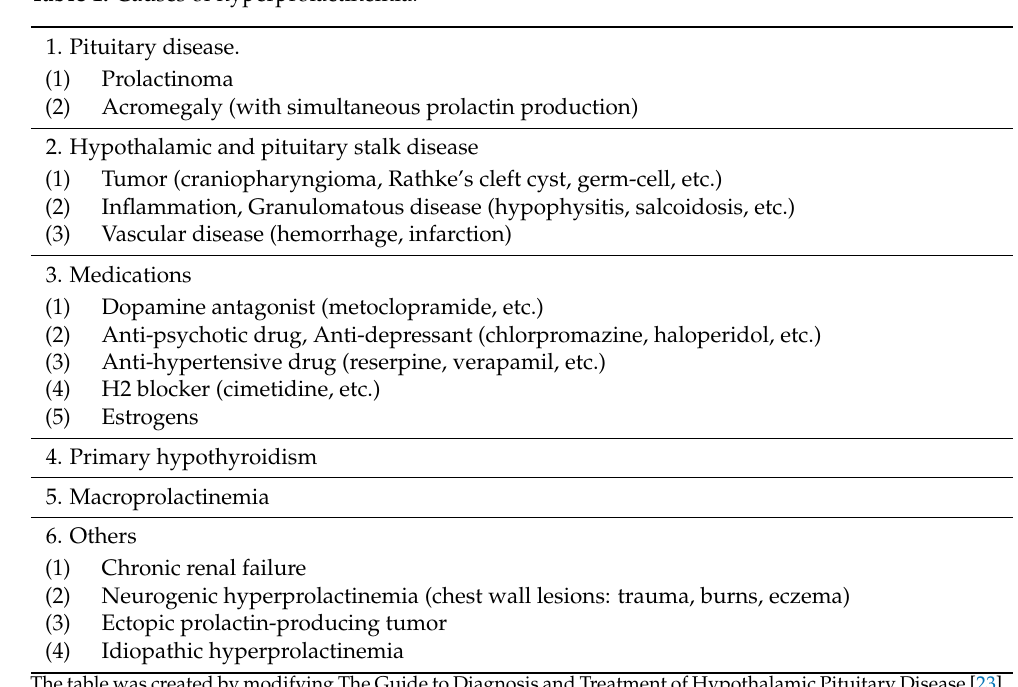
Table 1. Causes of